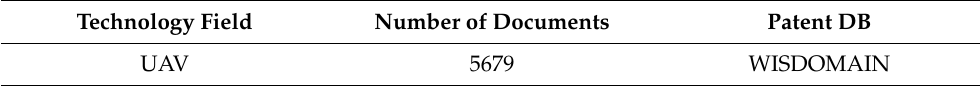
Table 1. Collected patent data.